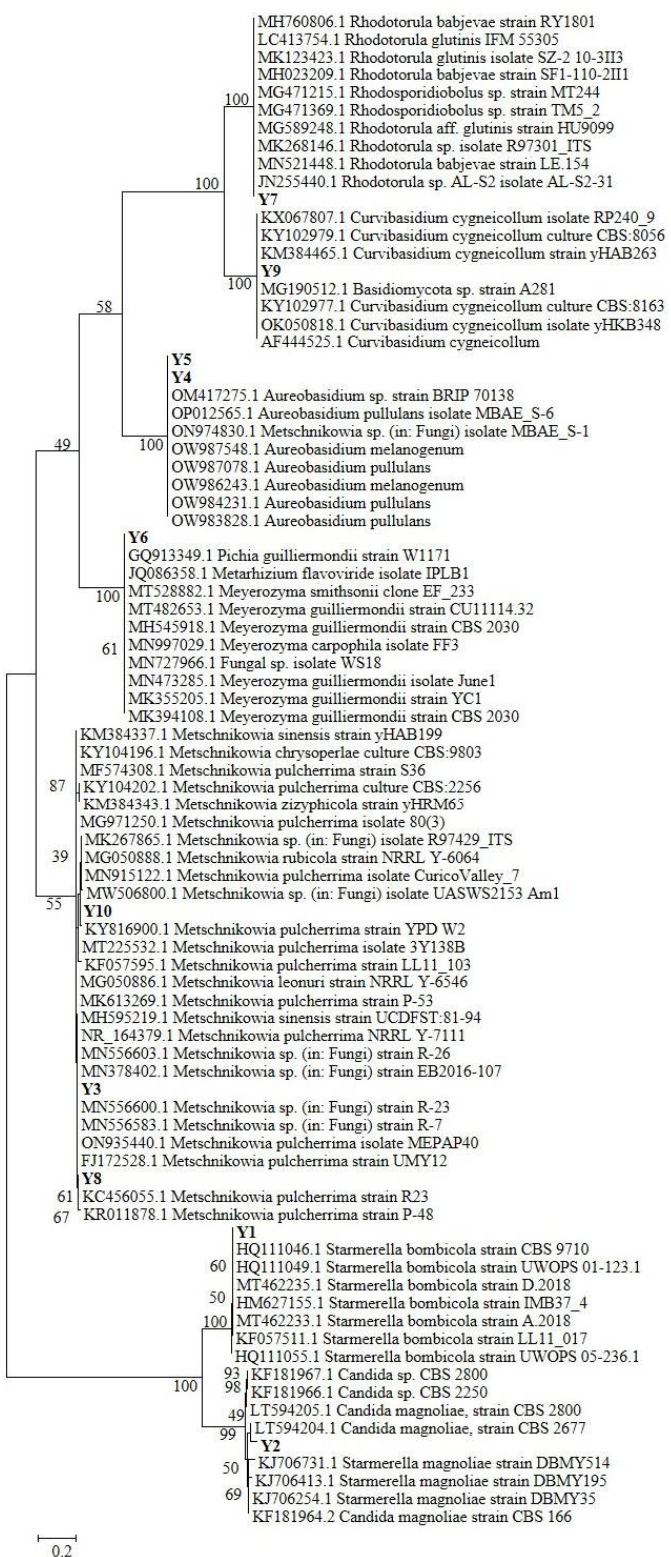
Figure 1. Maximum Likelihood phylogenetic tree reconstruction of the 10 sequences belonging to our yeasts isolates, aligned and compared with 75 high-quality sequences selected from international databases.